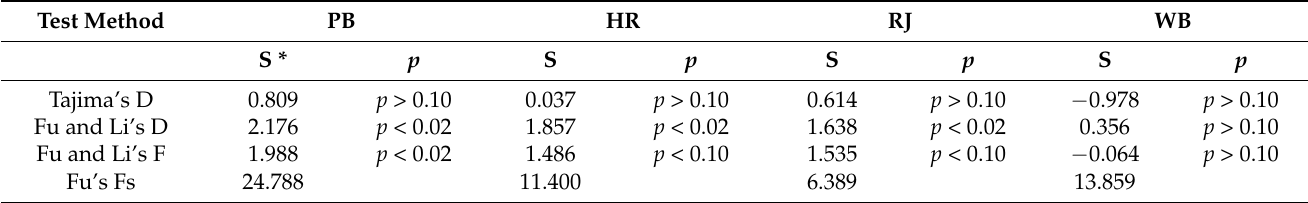
Table 5. Haplotype frequency (Freq) and distribution for F. graminareum isolates based on combined gene loci.